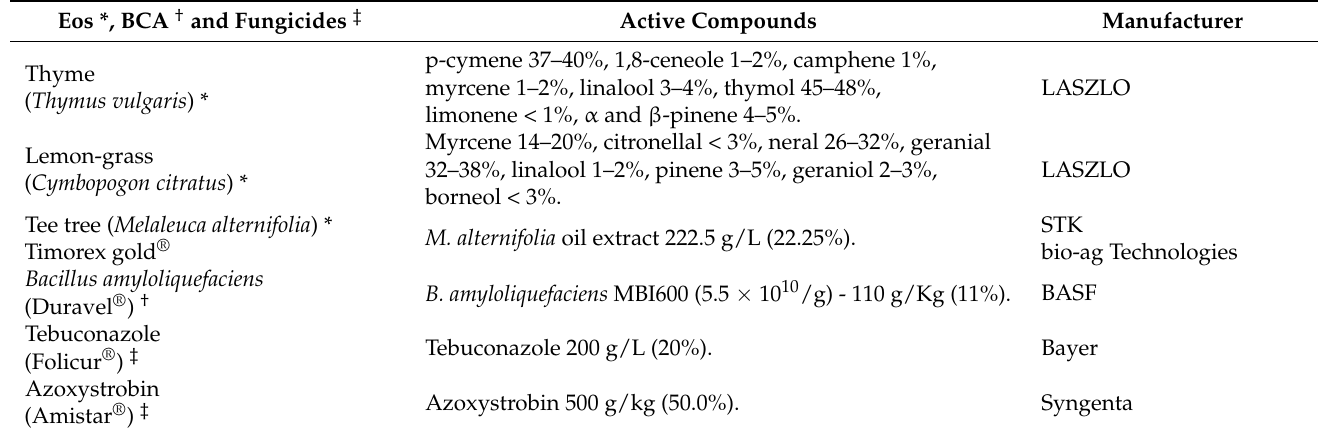
Table 1. Composition of essential oils, biological control agent and commercial chemical